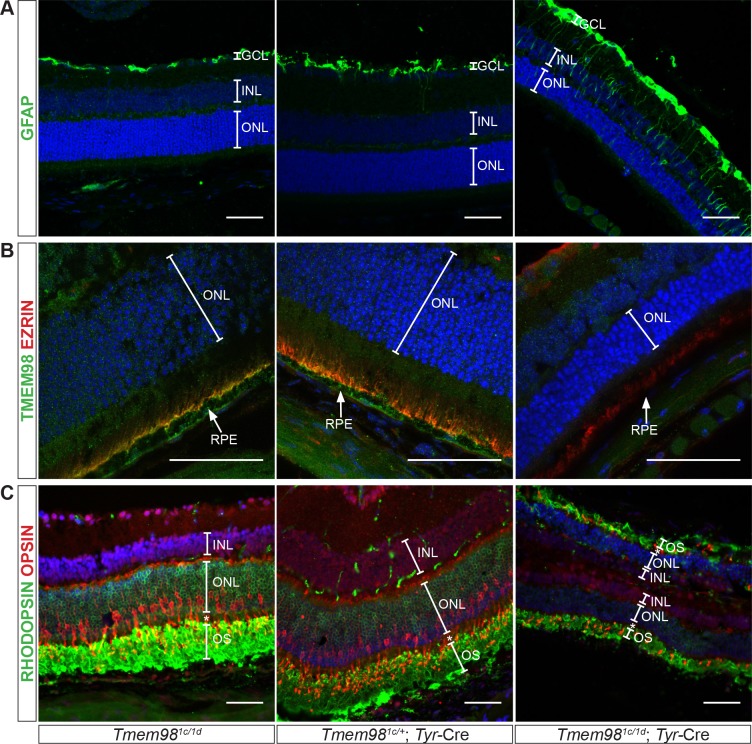
Characterisation of the retinal phenotype caused by loss-of-function of Tmem98.Immunostaining of adult retinal sections from control mice (Tmem98tm1c/tm1d (left) and Tmem98tm1c/+; Tyr-Cre (centre)) and mutant mice (Tmem98tm1c/tm1d; Tyr-Cre (right)). (A) Staining with an anti-GFAP antibody (green) shows that GFAP localisation is normal and seen only in the ganglion cell layer in the control retinas but extends down towards the inner nuclear layer in the mutant retina indicating retinal stress. (B) Staining with anti-TMEM98 (green) and anti-EZRIN (red) antibodies. In the control retinas TMEM98 staining is seen in the apical and basal layers of the RPE and EZRIN is localised to the apical microvilli, co-localisation of the two proteins is indicated by yellow staining. In the mutant retina TMEM98 staining is absent and EZRIN appears to be mislocalised. (C) Staining with anti-RHODOPSIN (green) and anti-OPSIN (red) antibodies marking rods and cones respectively. Normal staining is observed in the control retinas but in the mutant although RHODOPSIN and OPSIN are present the outer segment layer is very thin. In the mutant the retina has folded back completely on itself. This is a processing artefact and reflects the fragility of the mutant retina. DAPI staining of DNA is in blue. Abbreviations: inner nuclear layer (INL), outer nuclear layer (ONL), outer segments (OS) and retinal pigment epithelium (RPE). The retinas shown in (A) and (B) were collected from P21 littermate male mice. The retinas shown in (C) were collected from 9 week old littermate male mice. Scale bars represent 50 μm.